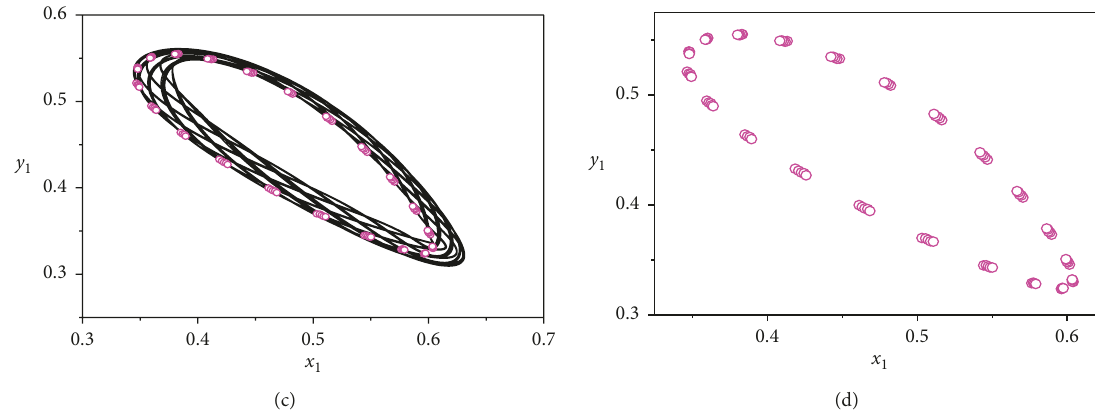
Figure 7: ω � 3.35: (a) displacement response; (b) frequency spectrum; (c) rotor orbit; (d) Poincar´e maps.